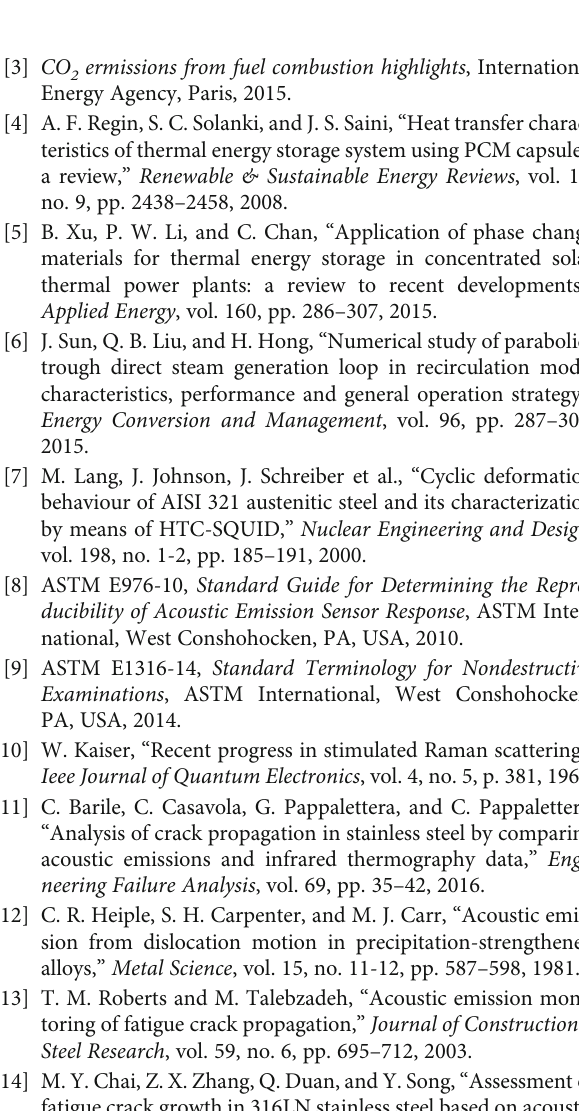
Figure 12: Trend of amplitude with time. The whole test was divided into three stages by the peak